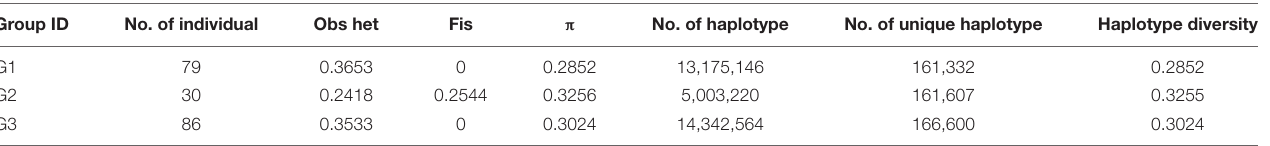
FIGURE 3 | (A) The geographic location of the origins of each accession in China and worldwide. (B) Phylogenetic dendrogram constructed by the neighbor-joining method. The accession name is represented by the accession code, which is coincident with Supplementary Table 1 . (C) Principal component analysis (PCA) of accessions, with the proportion of variance explained by each PC indicated in parenthesis. Dots of different color indicate different cluster groups. (D) Linkage disequilibrium measures ( r 2 ) against physical distance between pairs of SNP markers for the three major groups. TABLE 2 | The genetic diversity estimated of three major